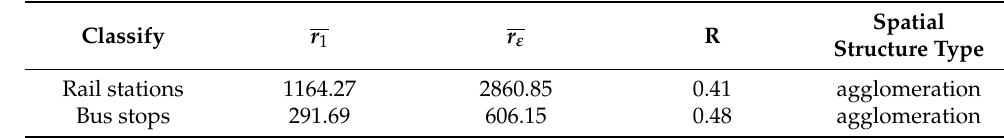
Table 2. Nearest Neighbor Ratio for public transport.